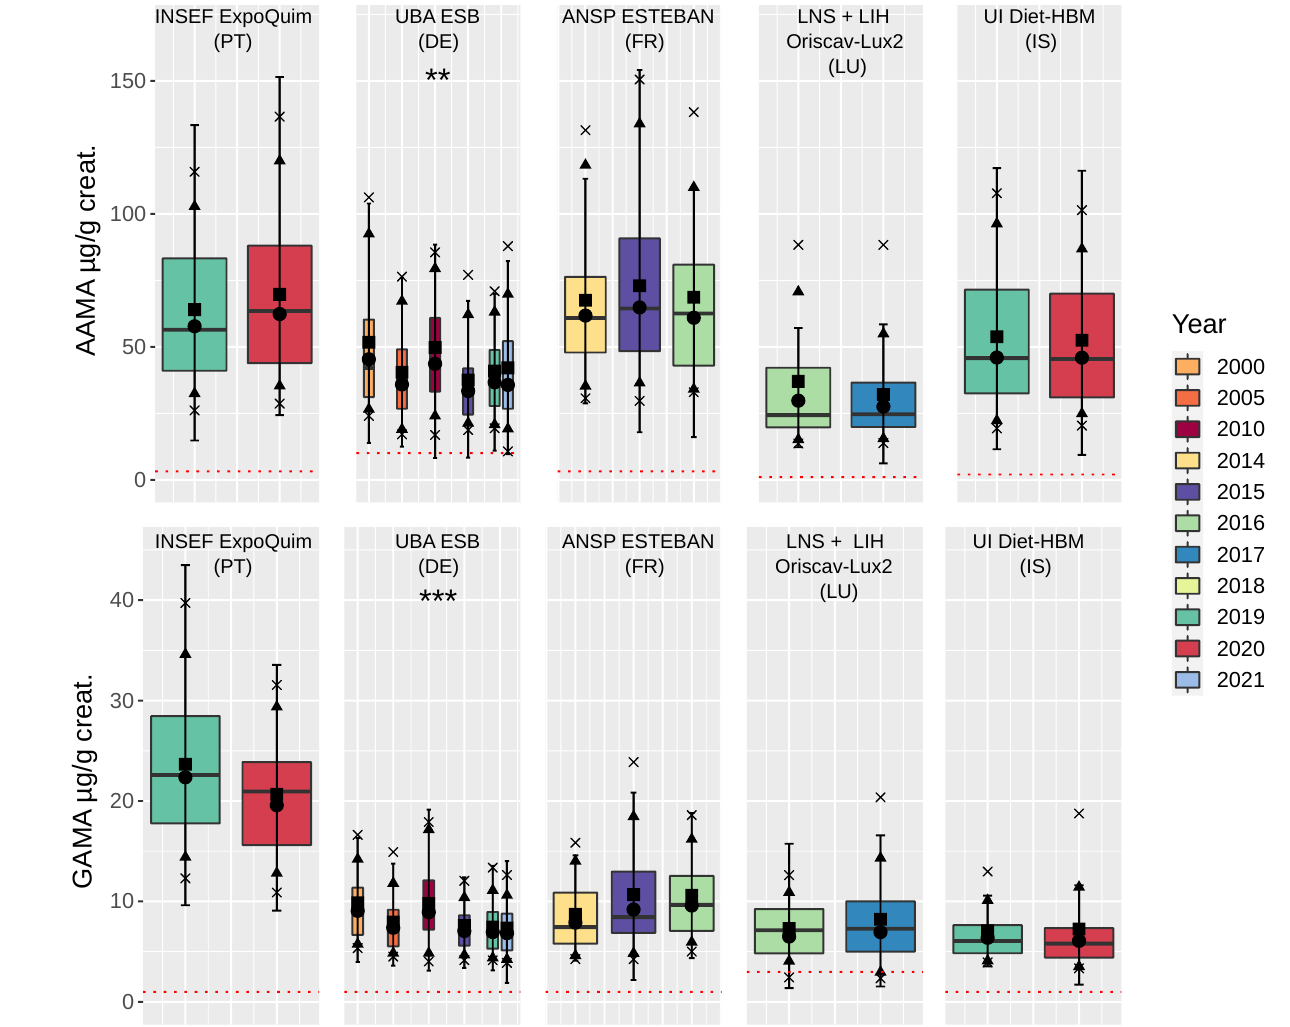
Figure 3. Boxplots of yearly mean (geom. mean, median) AAMA (top) and GAMA (bottom) in adults, based on data (non-smoker) of HBM4EU-aligned studies (Portugal, INSEF-ExpoQuim; Germany ESB; France, ESTEBAN; Luxembourg, LNS + LIH Oriscav-Lux2; and Iceland, Diet-HBM). Box = 25–75% interquartile range; line = median; (cid:110) = mean; (cid:108) = geometric mean; (cid:115) = 10 + 90% quantile; and x = 5 + 95% quantile. Dotted red line: level of quantification (LOQ). Asterisks indicate significant differences in (ln)AAMA and (ln)GAMA in µg/g creatinine (one-way ANOVA), *** p < 0.001, ** p <